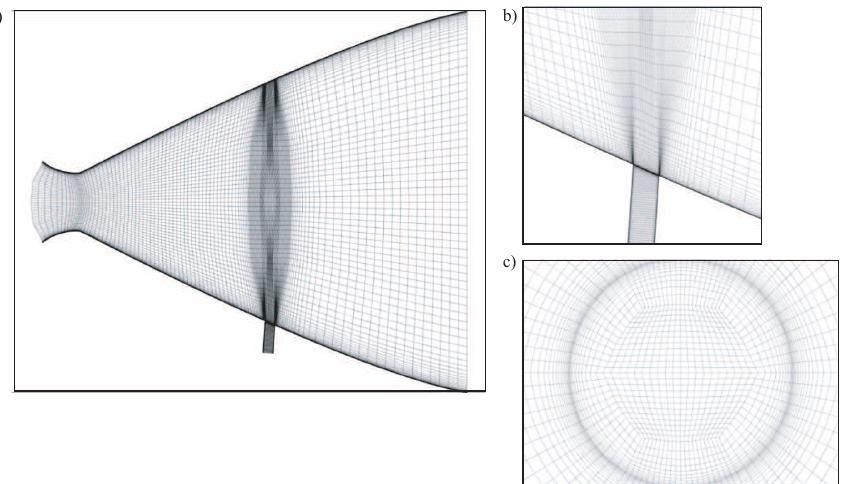
Figure 5. Computational mesh ( a ), mesh near injection port ( b ) and mesh in cross section of the injection port ( c ) with l j = 0.5, α j = 110 ◦ , d 2 / d 1 = 1, A ∗ / A a =